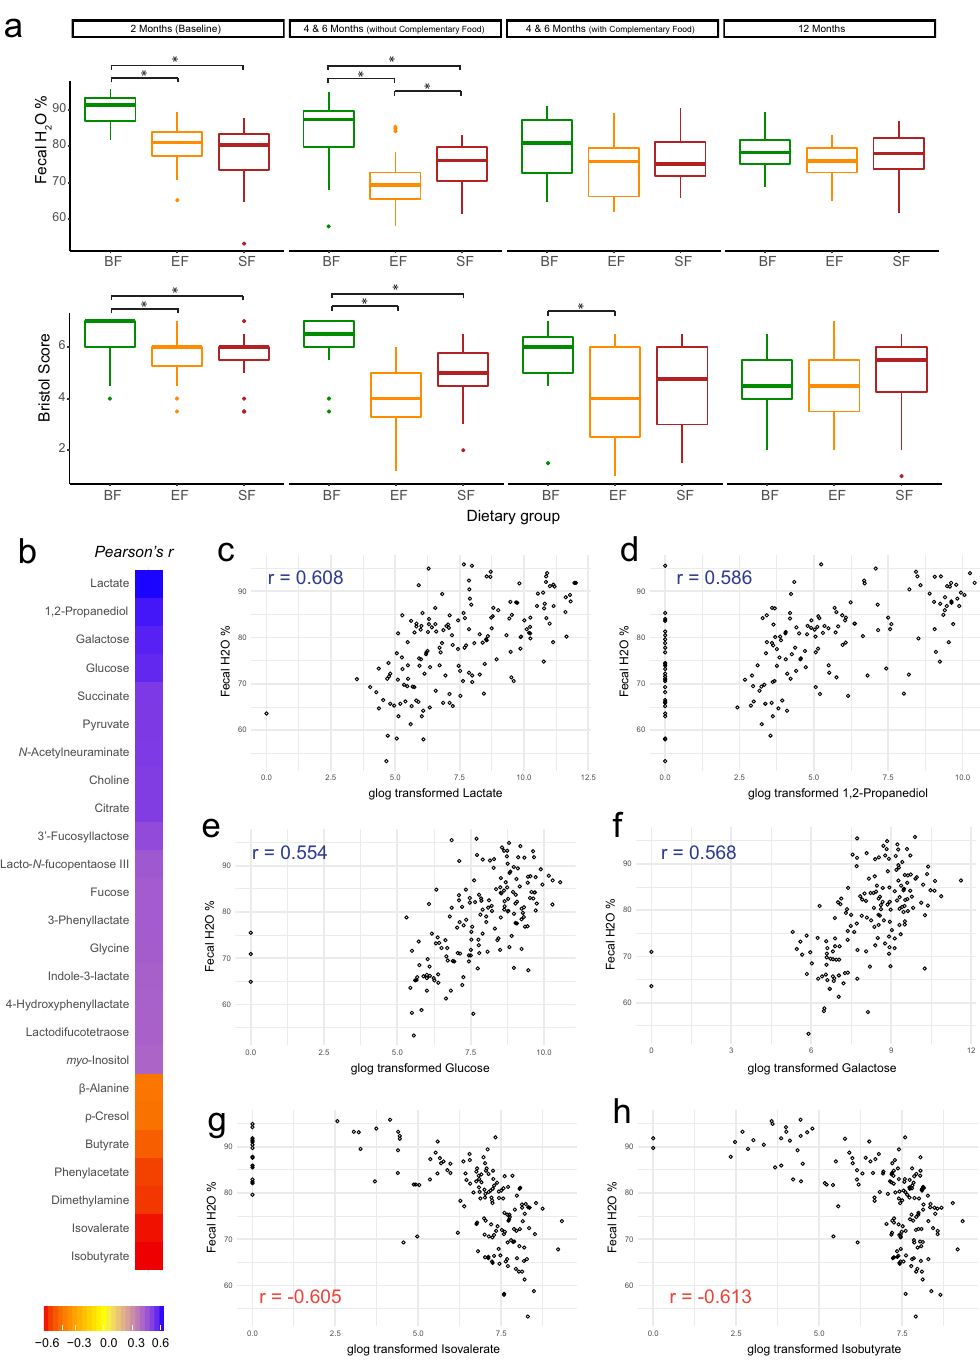
Figure 3. ( a ) Fecal water % and Bristol score are significantly higher in the breast-fed (BF) infants during the exclusive feeding period. The group difference was evaluated using Kruskal-Wallis H test followed by a post- hoc Dunn test, p < 0.05. Fecal metabolite concentrations are associated with fecal water %. ( b ) Heatmap of the correlation coefficient (Pearson r > 0.4 or <− 0.4, p < 0.05) of fecal metabolite concentrations correspond to fecal water %. Amount of water in infant stool is positively correlated with fecal concentration of ( c ) lactate, ( d) 1,2-propanediol , ( e ) glucose and ( f ) galactose and is negatively correlated with ( g ) isovalerate and ( h ) isobutyrate. The correlation between fecal water % and metabolite concentration were evaluated using data collected from 2 months (baseline) and 4 and 6 months (without complementary